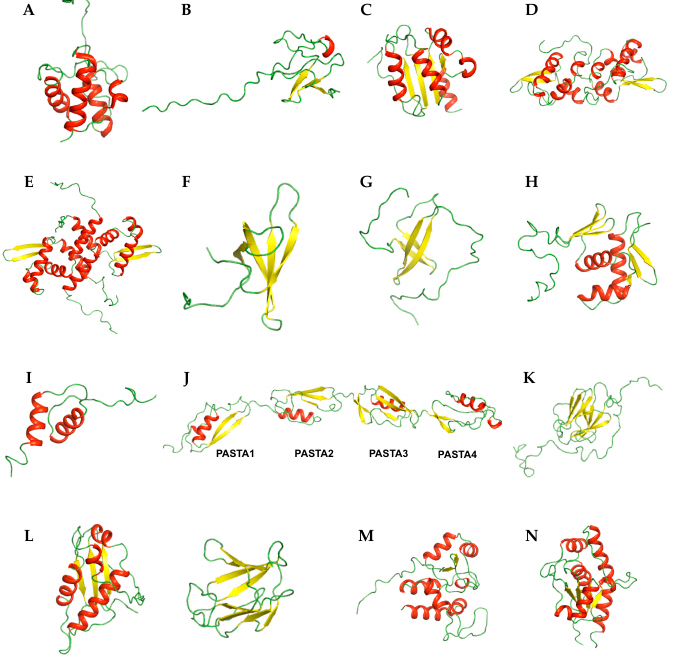
Figure 1. Ribbon representation of NMR structures of M . tuberculosis proteins. Transport-related